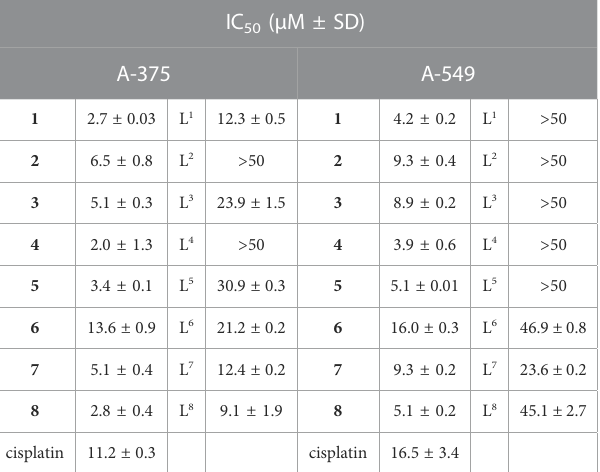
TABLE 5 IC 50 values of selected copper complexes 1 – 8, free ligands (L) and cisplatin (µM ± SD) on A-375 and A-549 cell